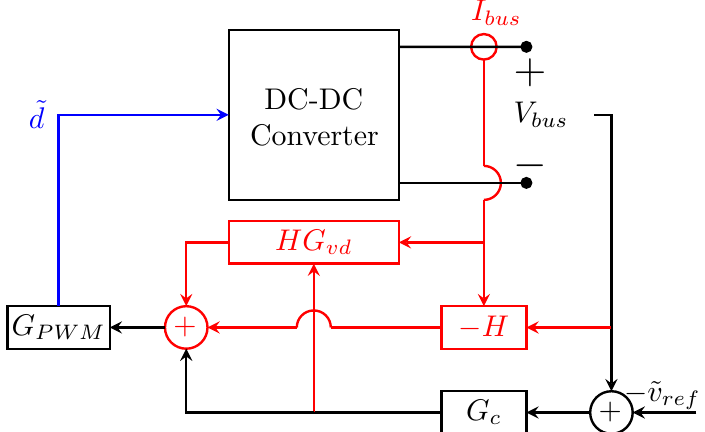
Figure 5. The proposed controller for the line regulating converter, where modifications to original controller are highlighted in